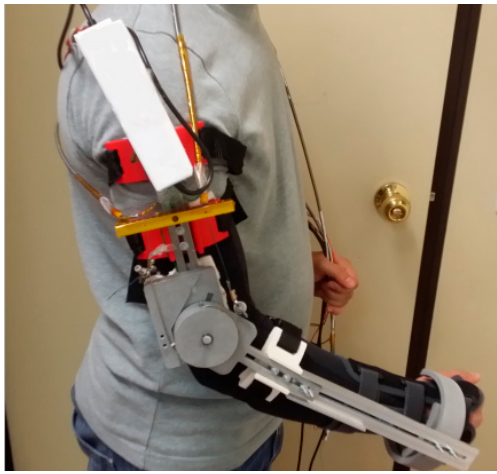
Figure 13. The SMA actuated exoskeleton with two DOF for flexion-extension and pronation- supination [35].